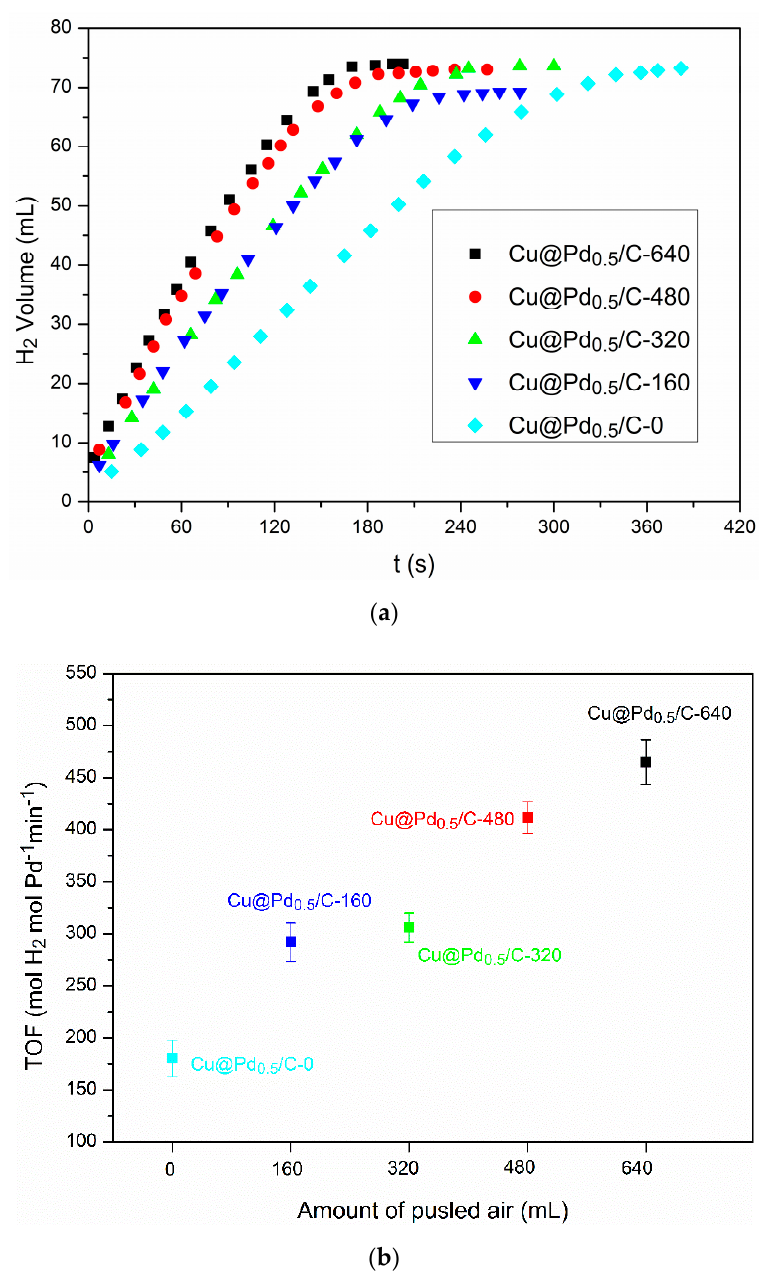
Figure 7. Plots of hydrogen evolution from ammonia borane vs. time over Cu@Pd/C prepared from Cu/C with different oxidation degrees ( a ) and the corresponding turnover frequencies (TOFs) ( b ). Table 1. Catalytic activity for the reported palladium catalysts in the hydrolysis of ammonia borane (AB).